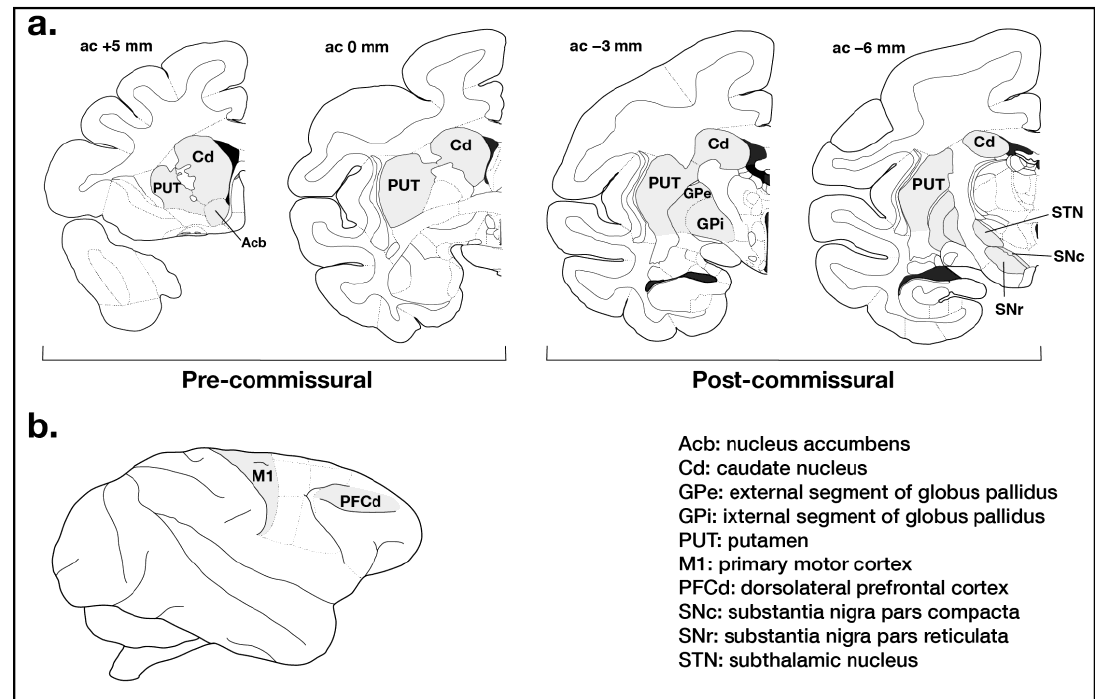
Figure 2. ( a ) Schematic representation of macaque ( macaca fascicularis ) brain showing stereotaxic coordinates [53], where caudate nucleus (Cd), putamen (PUT), nucleus accumbens (Acb), external (GPe) and internal (GPi) segments of globus pallidus, whole substantia nigra (SNc and SNr parts), and subthalamic nucleus (STN) were dissected for Western blot experiments. ( b ) Lateral view of macaque brain showing anatomical regions where primary motor cortex (M1, including regions controlling foot, trunk, and hand) and dorsolateral prefrontal cortex (PFCd) were dissected for Western blot experiments.